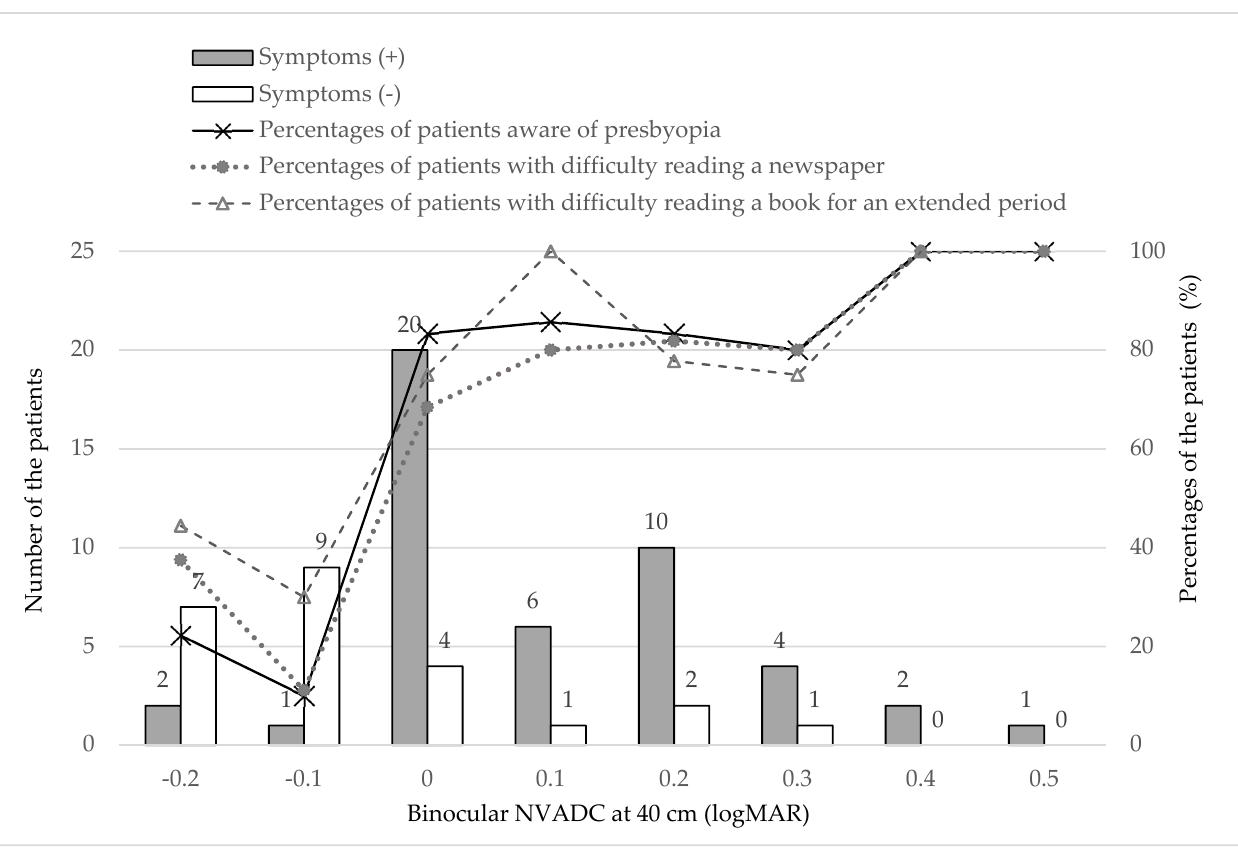
Figure 4. Binocular NVAHC and the rates of the patients with awareness of presbyopia, difficulty in checking a newspaper, and difficulty in reading a book for a long time ( N = 70).